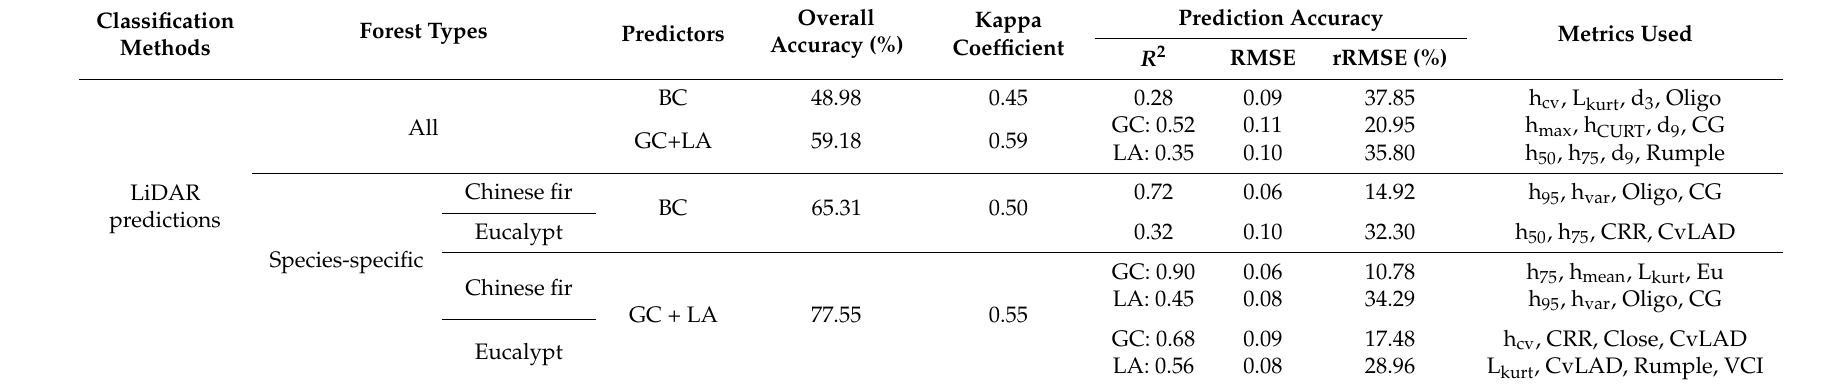
Table 4. Performance of modality differentiation using Light Detection and Ranging (LiDAR)